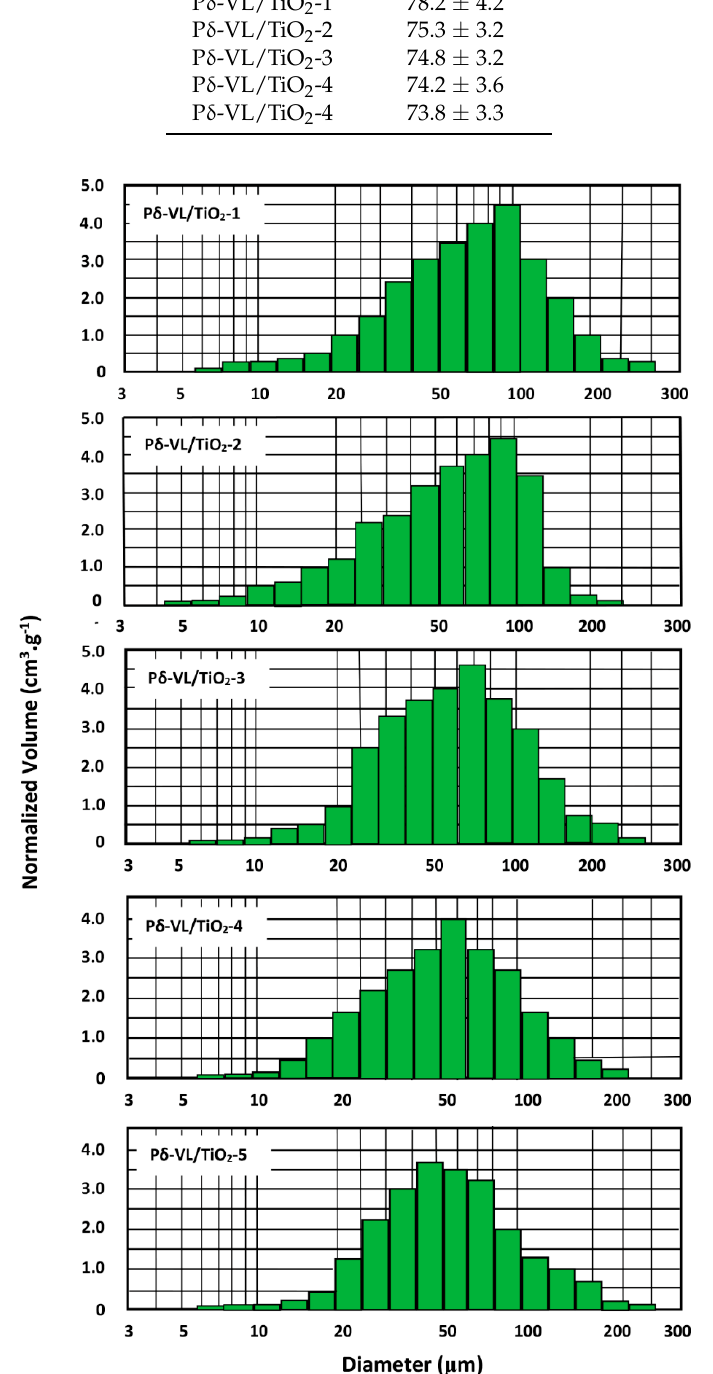
Figure 10. Pore sizes distributions in the microporous P δ -VL/TiO 2 hybrid materials with different TiO 2 contents .